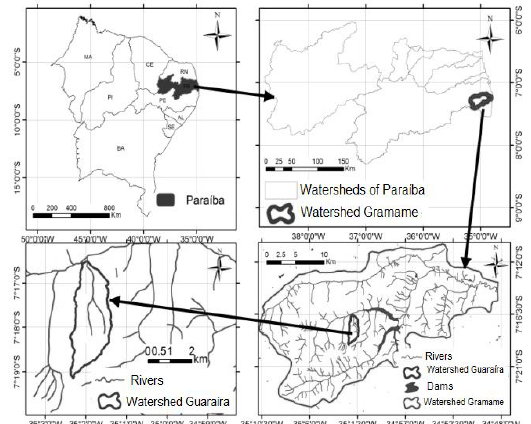
of northeastern Brazil, Paraíba State, the Gramame basin and the Guaraíra experimental basin